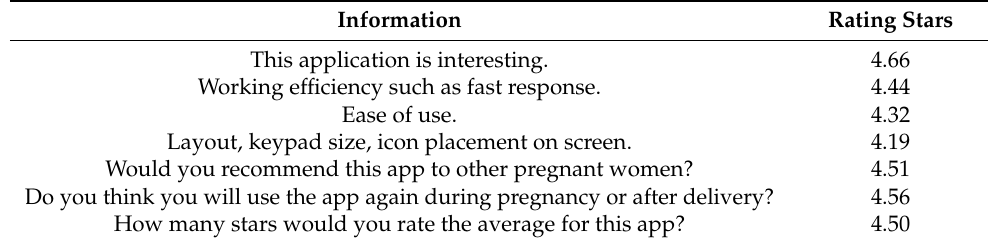
Table 15. Satisfaction test for using Z-Size Ladies, surveyed from 149 pregnant and postpartum